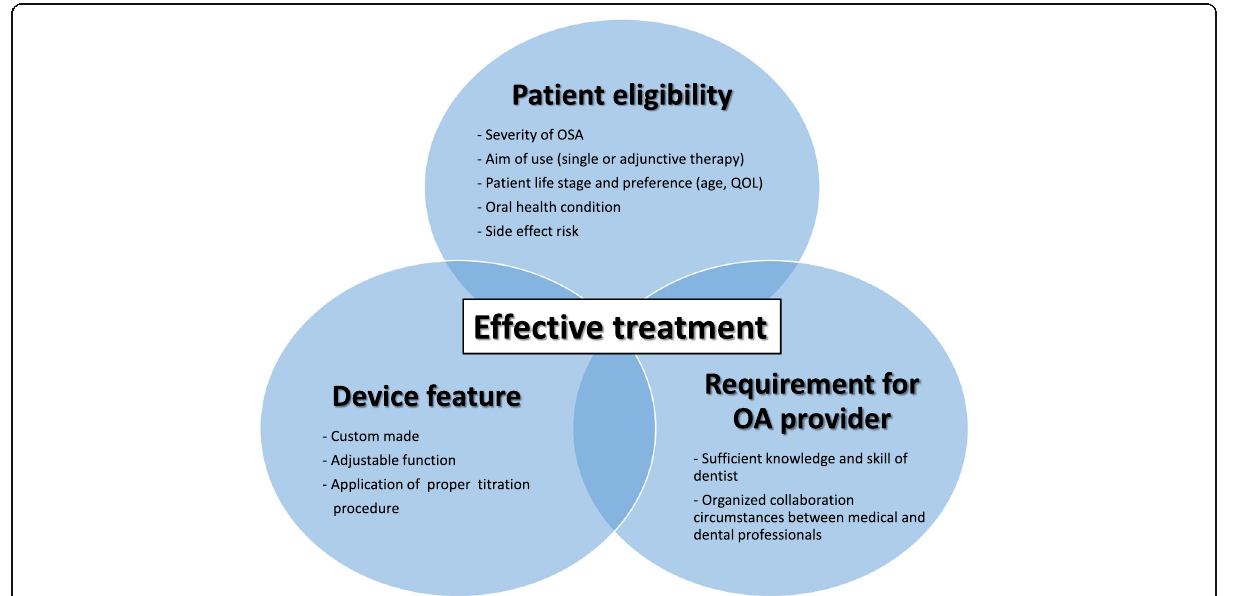
Fig. 1 Required components for successful OA treatment. All components must be considered when OA therapy is selected for OSA